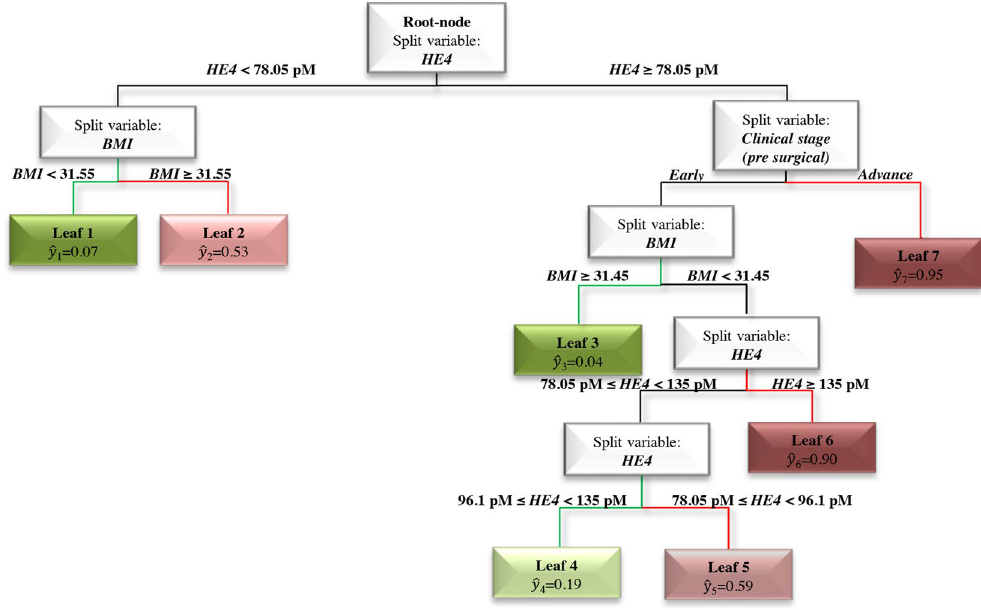
Figure 2. REpresentative Regression Tree (RERT) obtained on all 293 EC patients. In detail, ŷ is the relative frequency of patients, clustered within the same final node, having an advanced surgical stage (FIGO stage > I). Low or high values of ŷ can be interpreted as low (paths highlighted in green) or high (paths highlighted in red) probability of having a surgical FIGO stage > I, respectively.